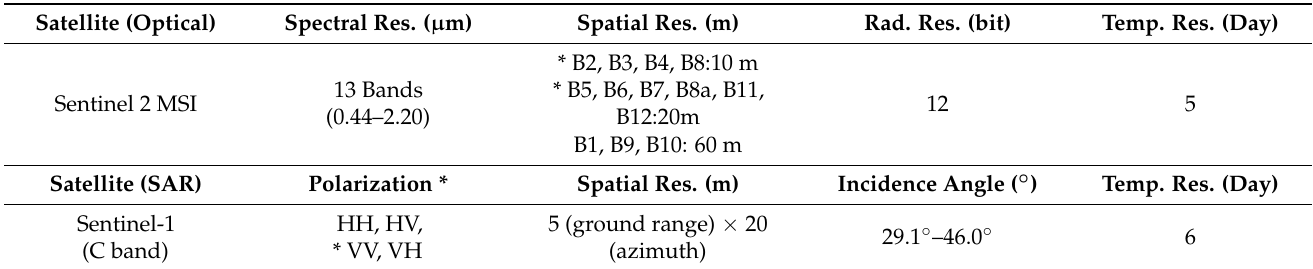
Table 1. Properties of Sentinel-1/-2. Text highlighted in bold refers to the chosen features.